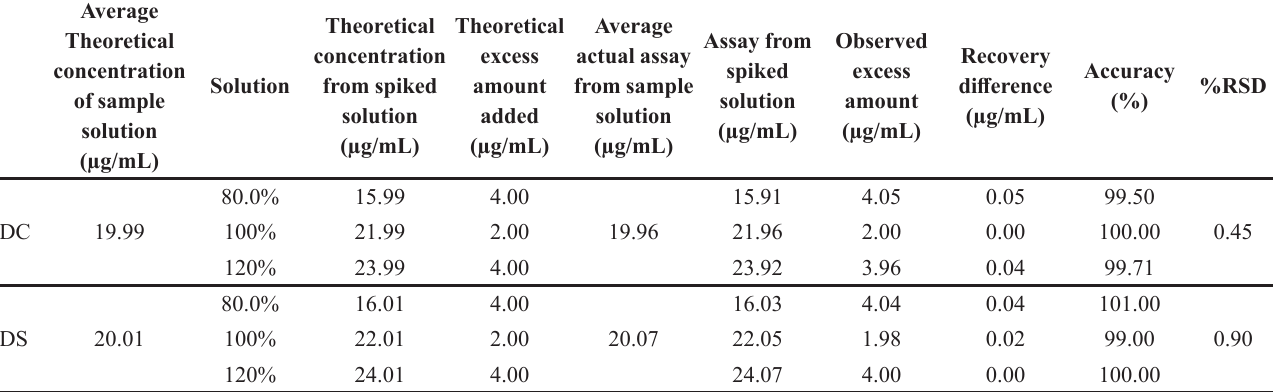
TABLEIII - Table for accuracy study DC and DS for chromatographic analysis Average Theoretical concentration of